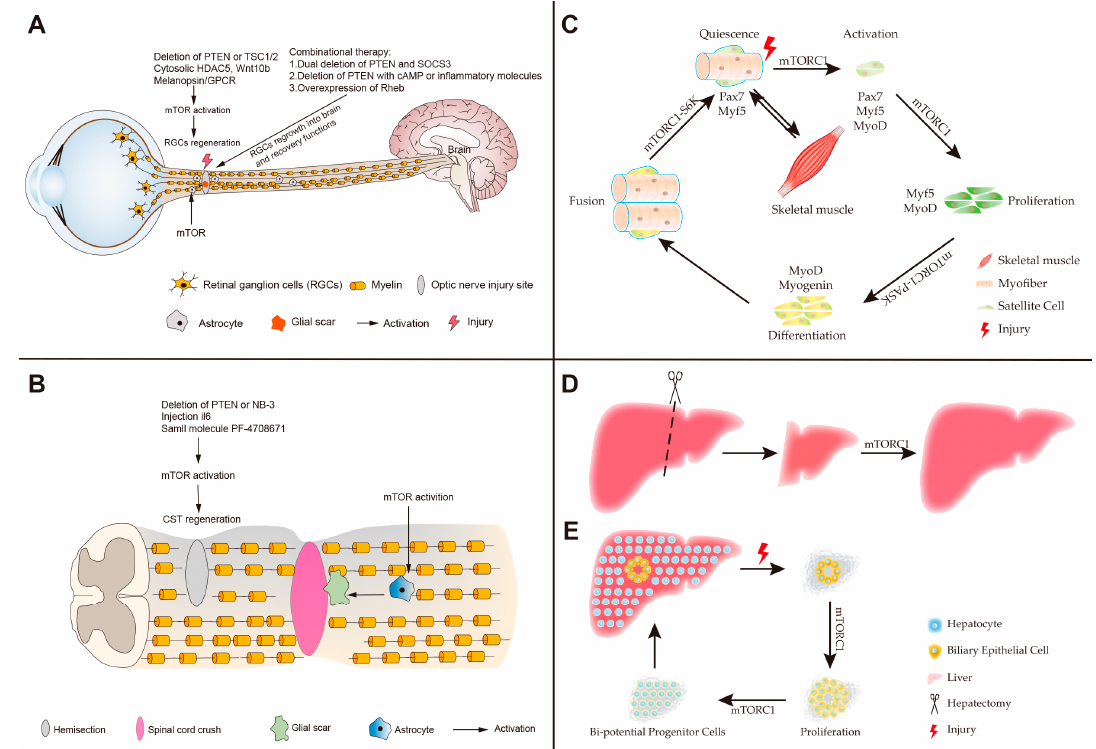
Figure 3. The roles of mTOR in the regeneration of neurons, muscles and the liver. ( A ) The optic nerve injury model. Activation of mTOR by deleting phosphatase and tensin homolog (PTEN) or tuberous sclerosis complex 1/2 (TSC1/2), the upstream cytosolic HDAC5 (histone deacetylase 5), Wnt10b (wingless-type MMTV integration site family, member 10b), and melanopsin/GPCR (cell-type-specific G protein-coupled receptor) robustly enhances the regeneration of retinal ganglion cells (RGCs). Combinational therapies augment the RGCs long-distance regeneration for visual function recovery through overexpression of Ras homolog enriched in brain (Rheb); the dual deletion of PTEN and suppressor of cytokine signaling 3 (SOCS3); deficiency of PTEN combined with injecting of cyclic adenosine monophosphate (cAMP) or inflammatory molecules (oncomodulin or zymosan). However, the excessive mTOR activation of astrocytes contributes to forming glial scar to inhibit axonal regeneration. ( B ) The spinal cord injury (SCI) model. In spinal cord crush model, the activated mTOR of astrocytes facilitates glial scar formation resulting in impeding the spinal cord regeneration after SCI. In the hemisection model, the stimulation of mTOR promotes the corticospinal tract (CST) regeneration post-SCI. ( C ) A schematic representation of skeletal muscle regeneration. mTORC1 stimulates satellite cells activation and proliferation, and their progenies di ff erentiate into myoblasts under mTORC1 regulation. mTORC1 also promotes the fusion of myoblasts to form myofibers. ( D ) Partial hepatectomy (PH) model. Liver regeneration after PH is via the self-replication of existing hepatocytes, and mTORC1 regulates hepatocyte proliferation. ( E ) The severe liver injury model. Liver regeneration is via the trans-di ff erentiation of cholangiocytes. In the process, mTORC1 regulates the proliferation of cholangiocytes and the formation of Bi-potential Progenitor